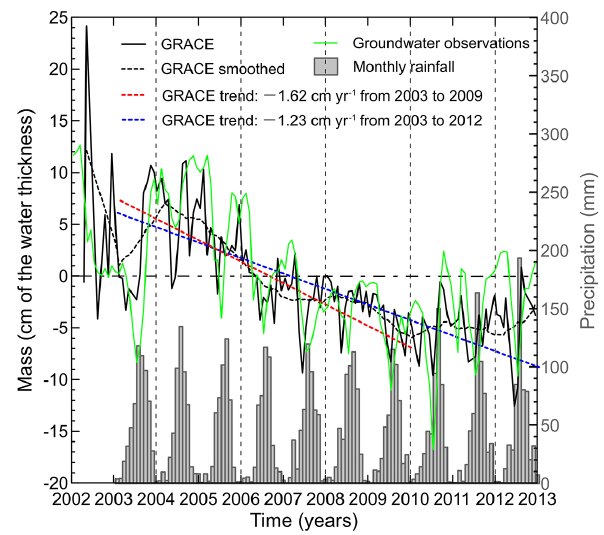
Figure 7. Time series showing total terrestrial water storage (TWS) changes in the spatially averaged area (kernel) of the NCP estimated from CSR GRACE data, monthly groundwater level changes ob- served by monitoring wells after multiplying by mean value of spe- cific yields in the NCP during 2002–2012 and the daily precipita- tion data (rainfall amount) for weather stations during the period of 2003–2012 from CMDSSS. The black dashed curve is the tempo- ral smoothing GRACE-based result, the red and blue dashed curve are the long trend of GRACE-based result during 2003–2009 and 2003–2012